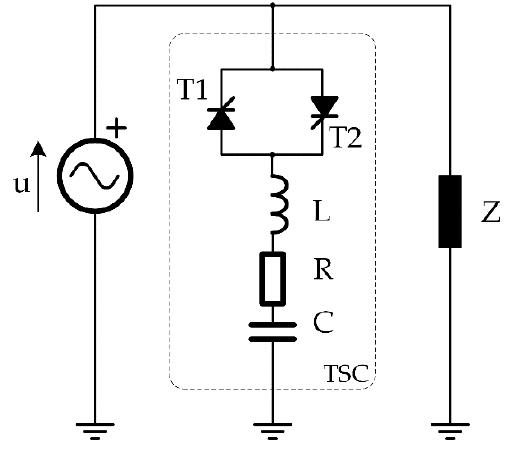
Figure 2. Generic thyristor switched capacitor (TSC) model [18].